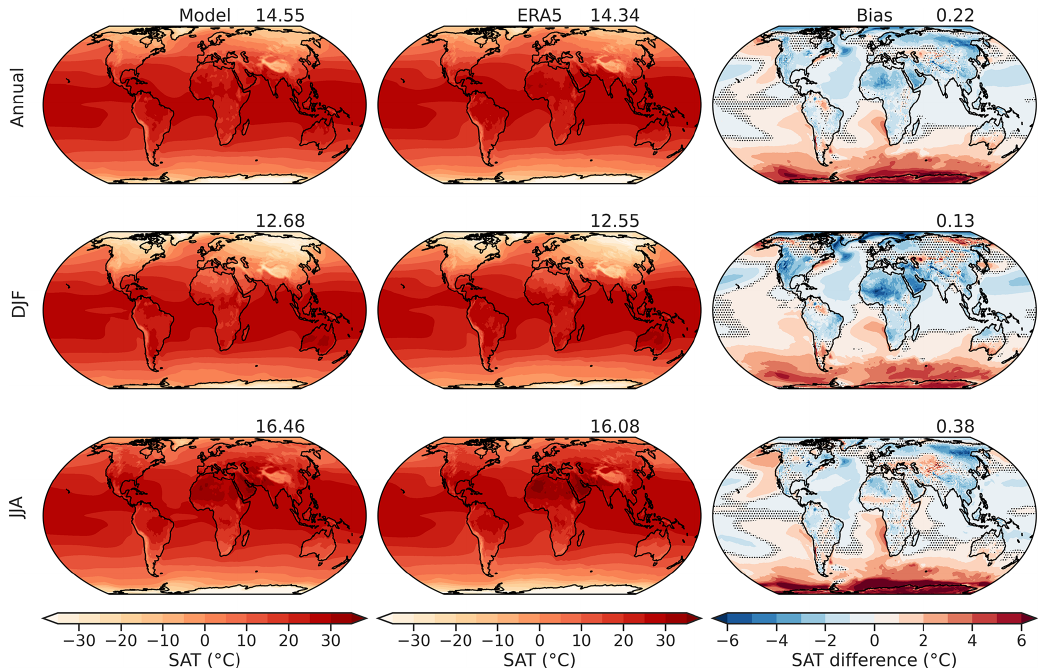
Figure 7. Surface air temperature (SAT) climatology for the years 1995–2014 from the four-member ensemble of the CMIP6 historical simulation and the ERA5 reanalysis (version 2), and the corresponding differences. The top row shows the full multiannual means, and the middle and bottom rows show the means for boreal winter (December, January, February; DJF) and summer (June, July, August; JJA), respectively. The number given in the top right of each panel is the global mean value. The stippled areas in the panels on the right indicate the regions where the differences are not significant at the 5% level, as determined from a two-sided unequal variances independent t test.